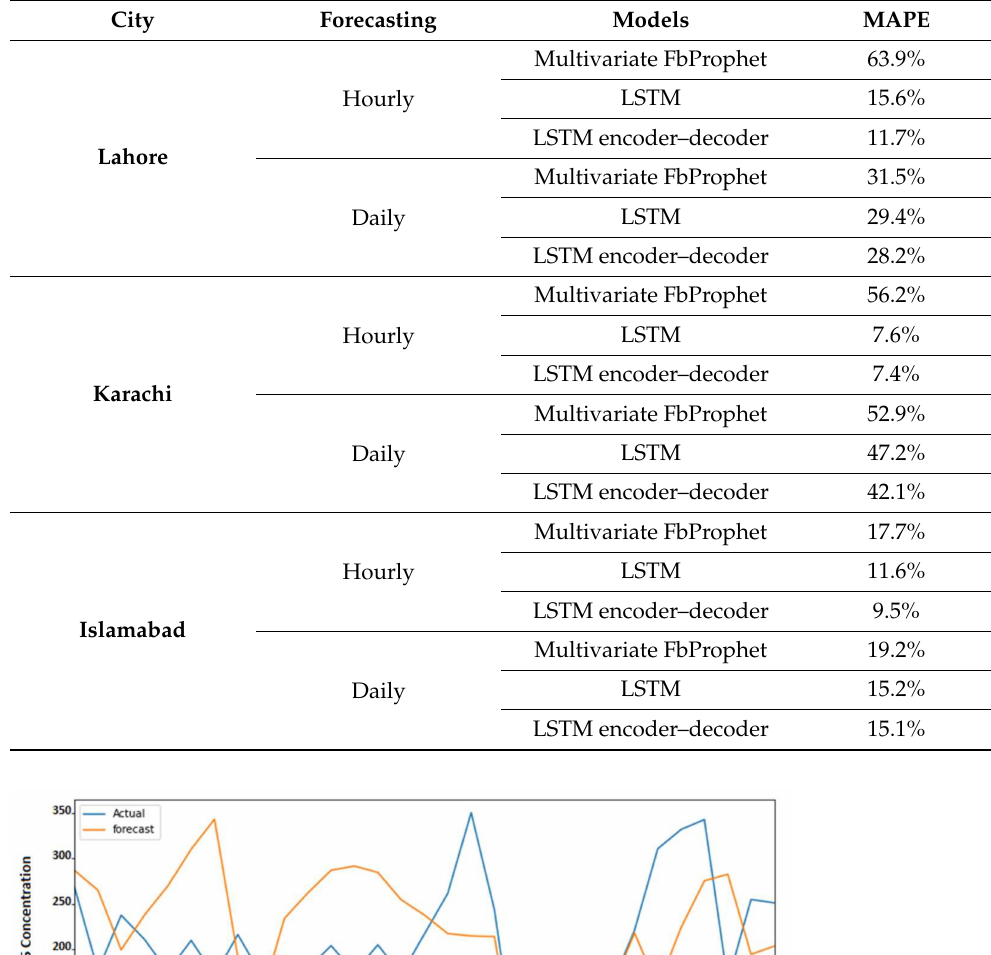
Table 7. Result for hourly and daily forecasting for all the proposed models in the Lahore, Islamabad, and Karachi datasets.